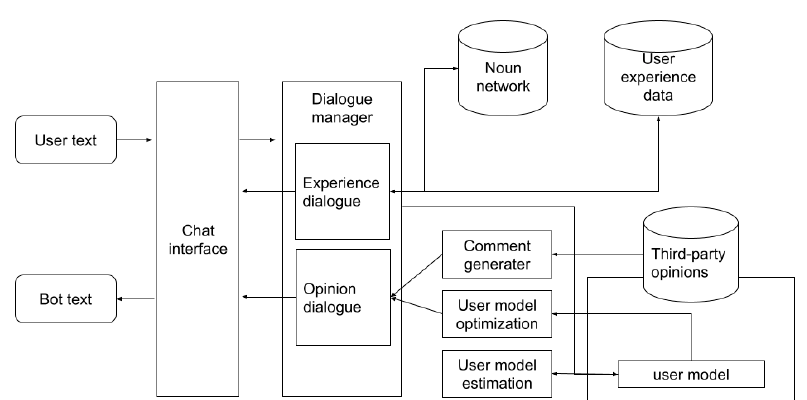
Figure 1. Process flow.